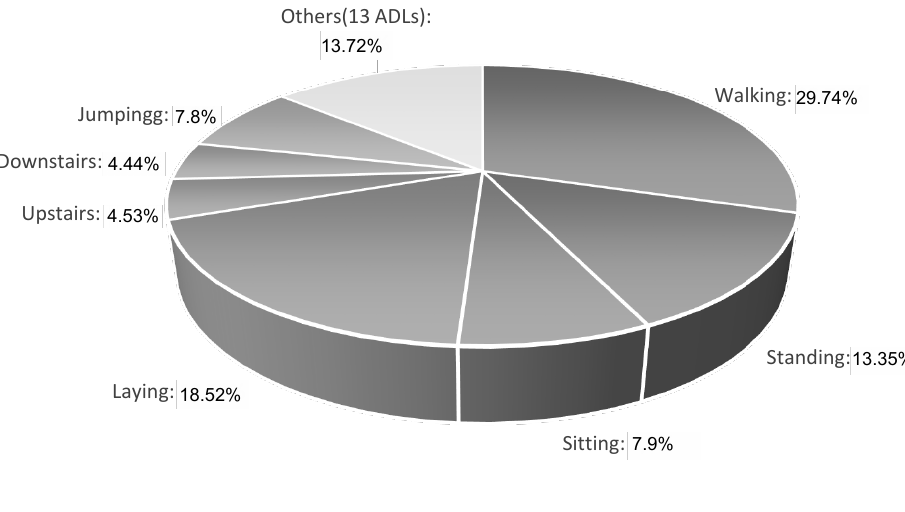
Figure 2. Percentage quantity of windows created of each activity present in the created dataset. The activities are named according to Table